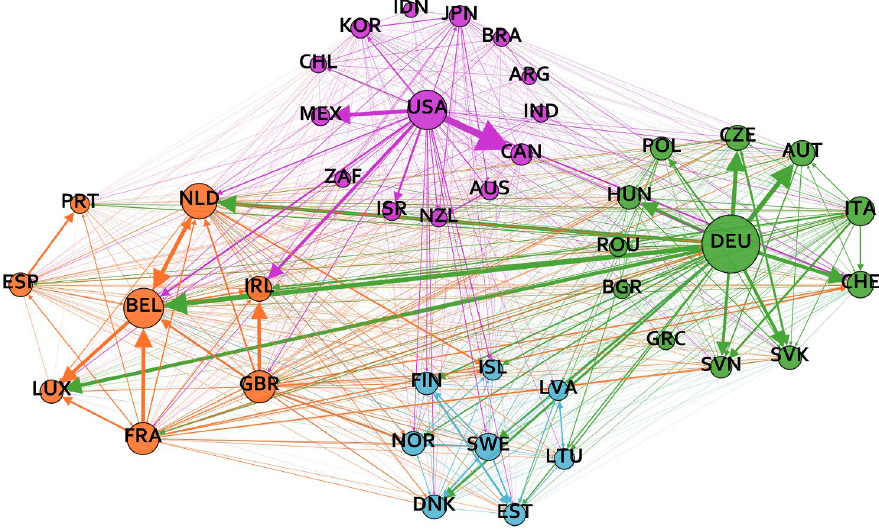
Fig 2. Relative trade openness network. The nodes of the graph are countries and the directed weighted edges refer to the average trade volume from country i to country j relative to the GDP of country j . The color of the nodes shows the module membership and the size of the nodes refer to the total degrees of